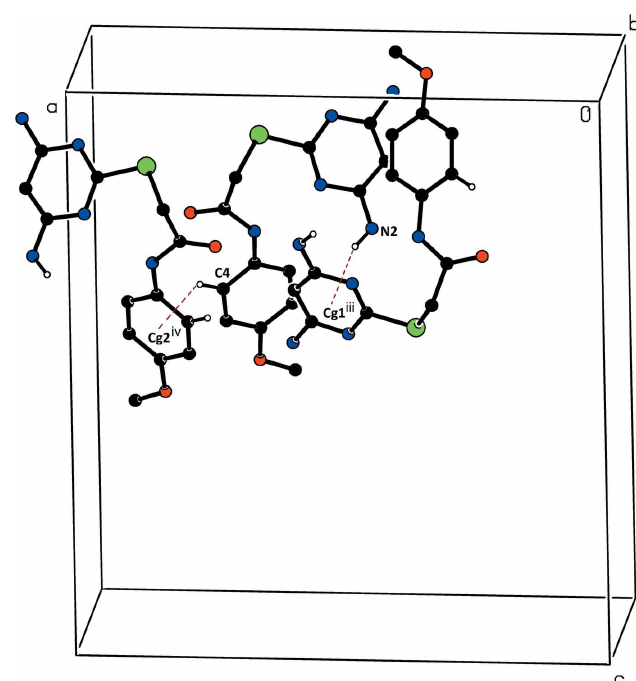
Figure 2 A packing diagram of the title compound, showing the N—H (cid:3)(cid:3)(cid:3) N and N—H (cid:3)(cid:3)(cid:3) O hydrogen bonds (dashed lines). Hydrogen atoms not involved in the hydrogen bonds have been omitted for clarity. [Symmetry codes: (i) (cid:4) x , (cid:4) y + 1, (cid:4) z ; (ii) x (cid:4) 1